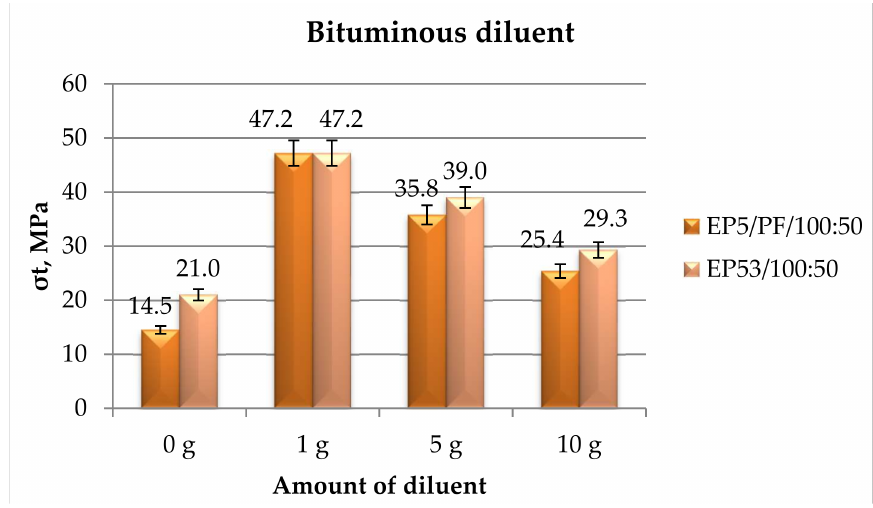
Figure 21. Tensile strength calculated for Epidian 5 and Epidian 53 epoxy compounds as a function of the amount of bituminous diluent.